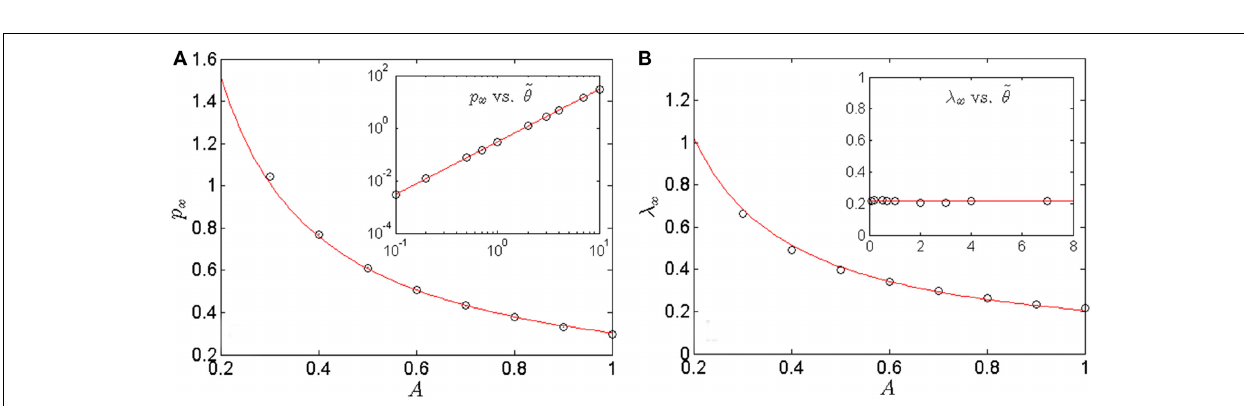
FIGURE 12 | (A) Slope p x associated with the curve S x vs .(cid:17) x as a function of A at constant ˜ θ = 1 (main) and ˜ θ at constant A = 1 (inset). In the inset, the axes are logarithmic. In both graphs, the red lines are fits p 1 = C x / A (main) and p 1 = C ˜ θ 2 where the fitted parameter is found to be C = 0 . 31 ± 0 . 02 (95%